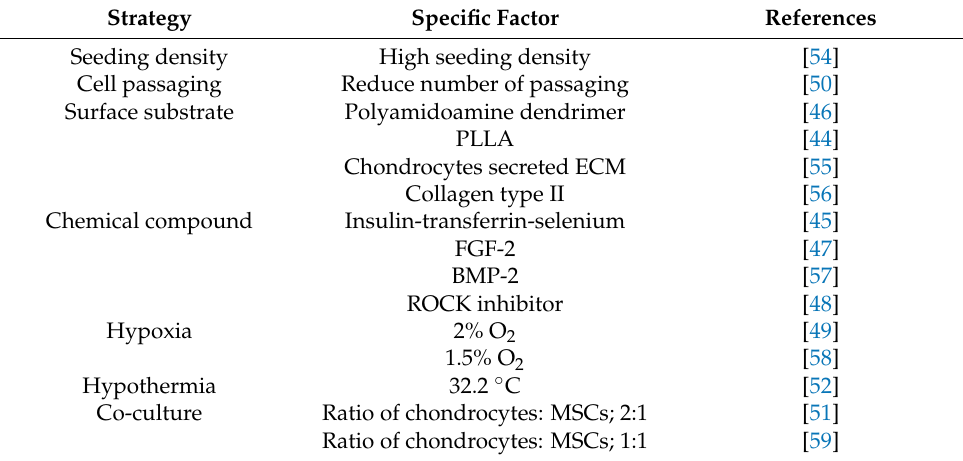
Table 3. Strategies to reduce dedifferentiation of cultured